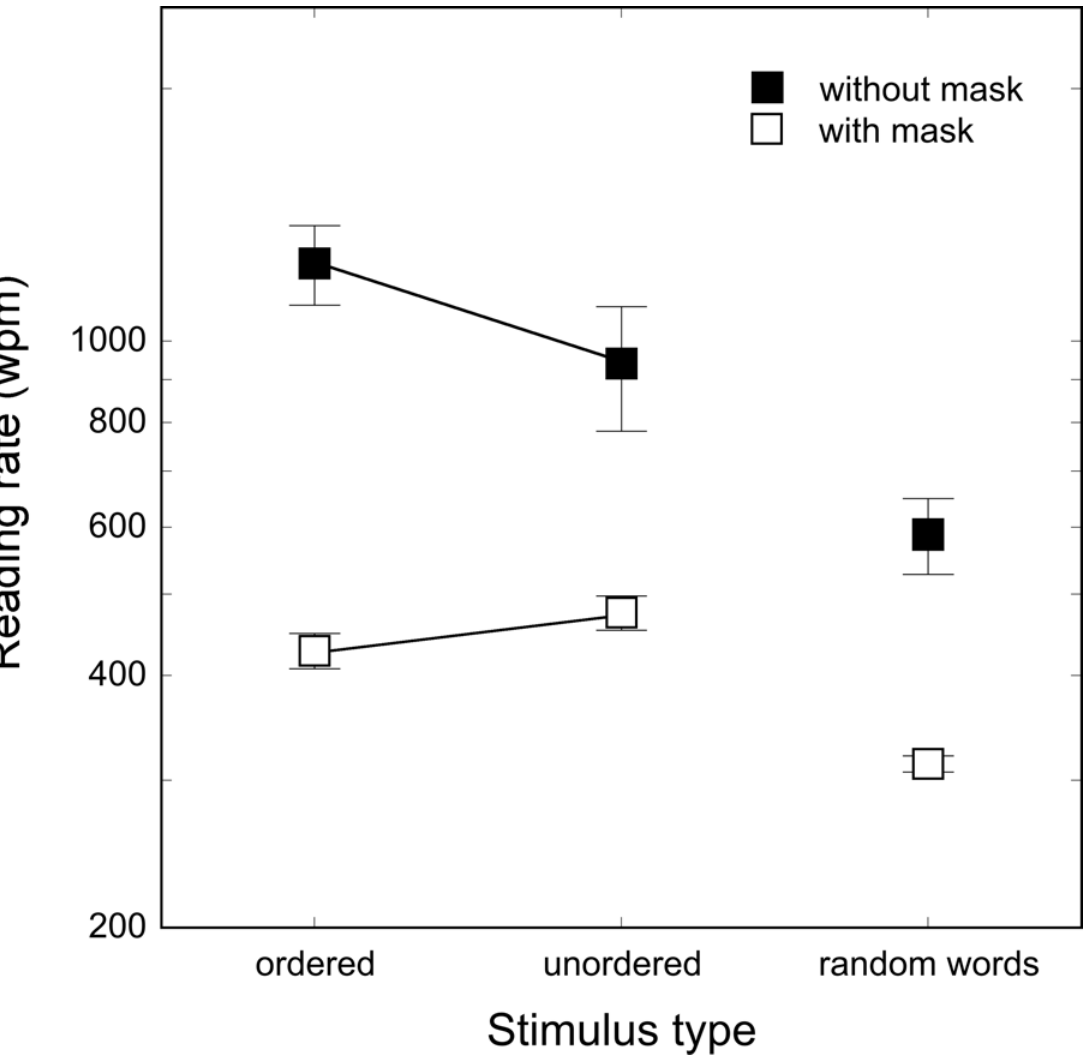
Fig 5. Reading rate for ordered text, unordered text and 4 – 6-letter random words. Bars represent standard deviations. Data were collected in two groups of subjects in the absence (black squares) or in the presence (white squares) of a non-verbal mask before the first word and after the last word in the